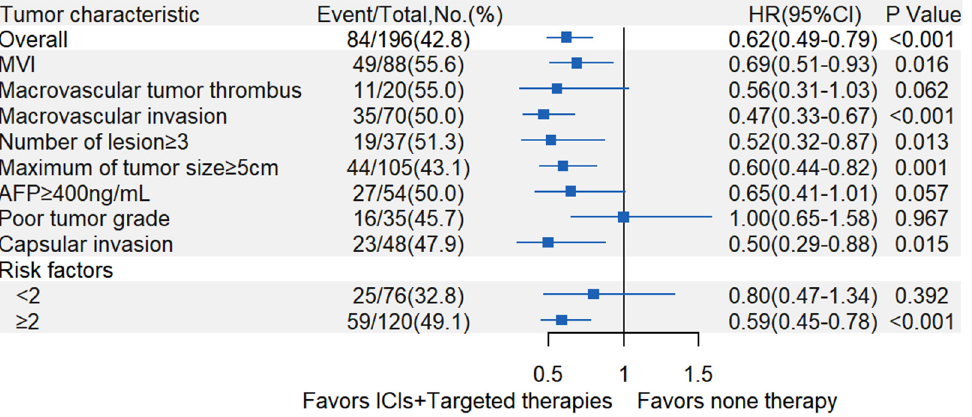
Figure 3. Forest plot for subgroup analysis of the comparison between control and treatment groups. MVI = Microvascular invasion; AFP = Alpha-fetoprotein.